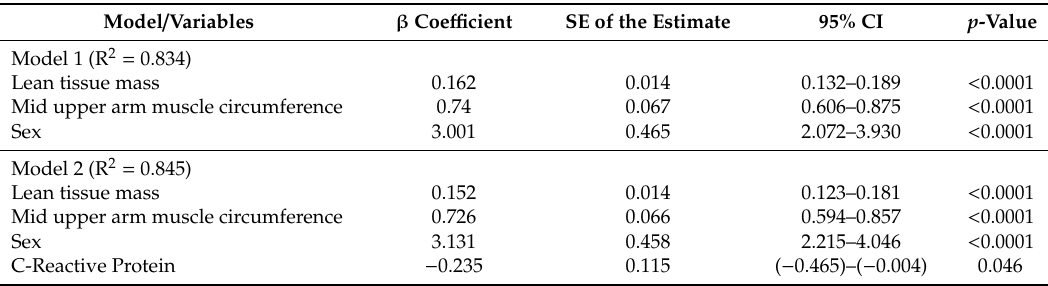
Table 4. Multivariable linear regression analyses to test de independent relationship between ICW and other clinical